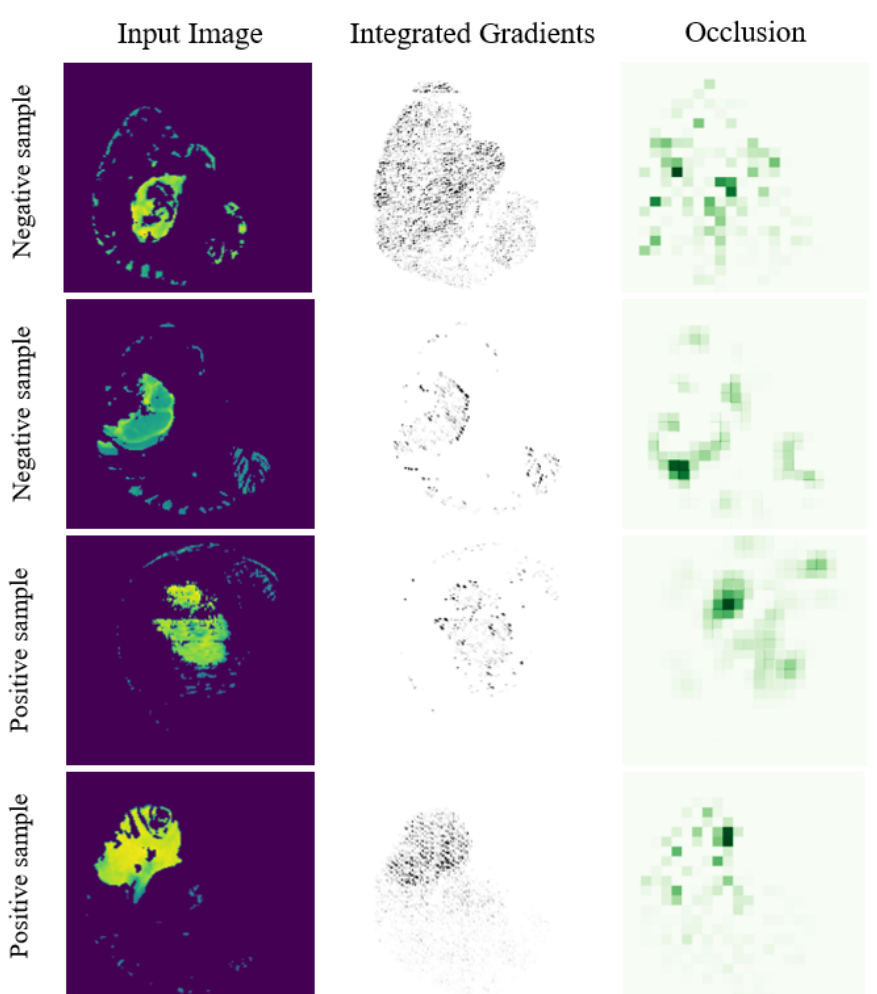
Figure 7. Results of the Integrated Gradients [28] and Occlusion [29] models considering four different inputs volumes. In the first two rows, we consider negative samples without the methylation process. The last two rows show positive instances, in which the methylation is